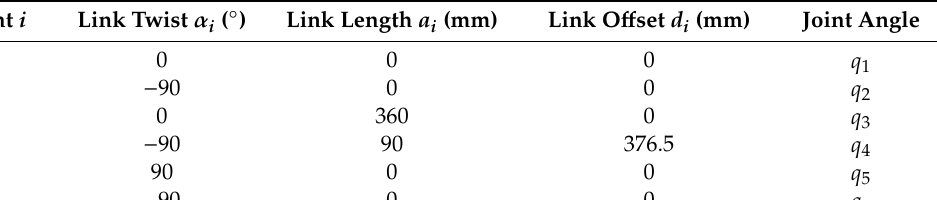
Table 1. Modified D-H parameters of Robot.